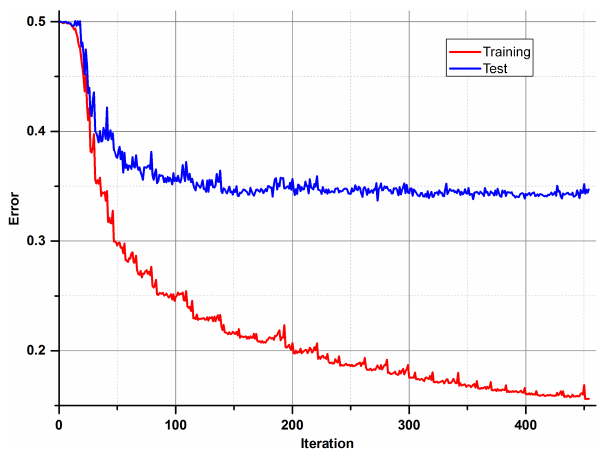
Figure 6. Example of error minimizing during the training process.